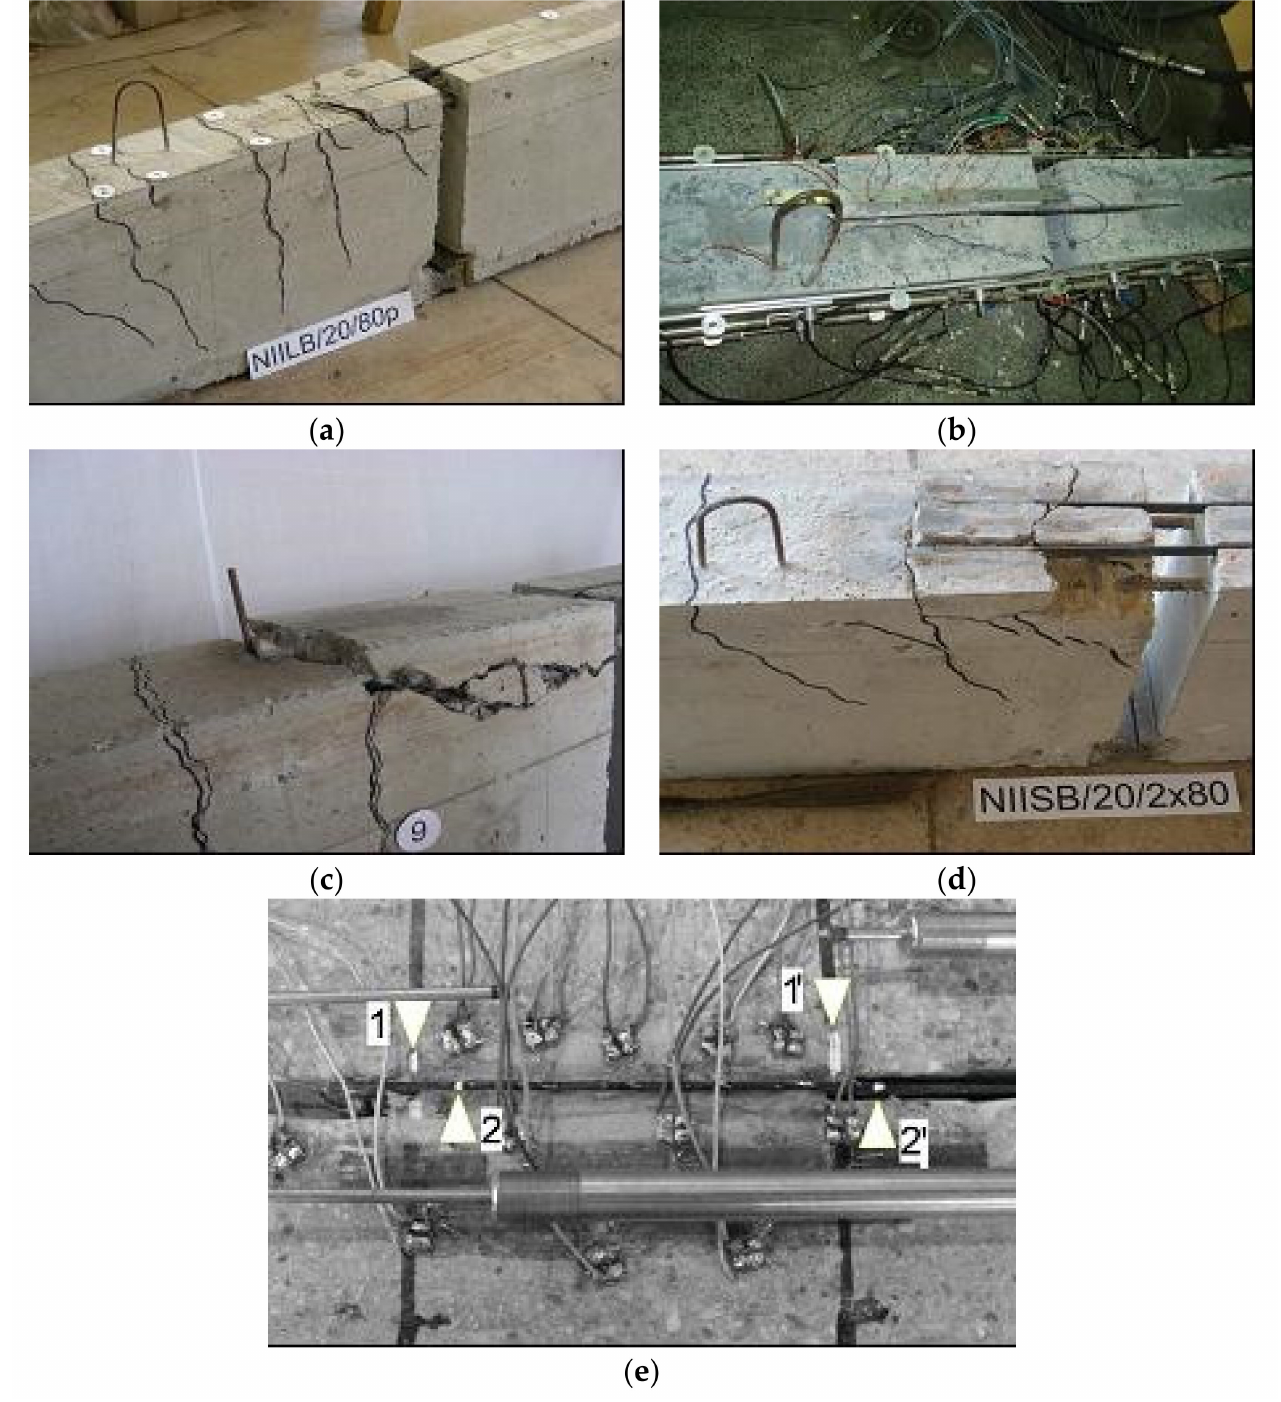
Figure 4. Different failure modes of specimens: ( a ) NIILB/20/80; ( b ) NISA/20/160; ( c ) NISA/20/80; ( d ) NIISB/20/2 × 80; ( e ) NILB/40/120s